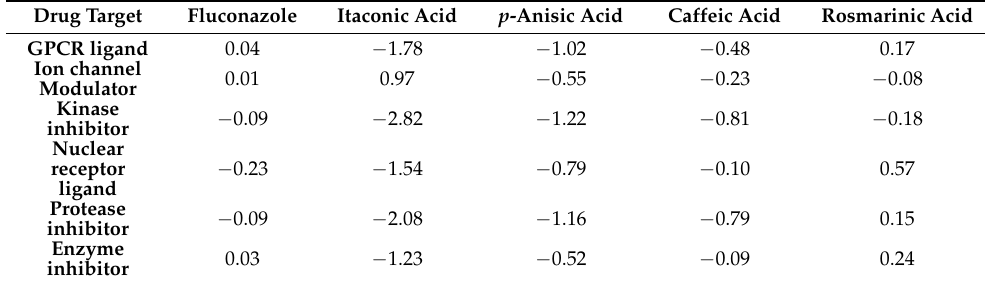
Table 4. Bioactivity score of test compounds as potential ICL 1